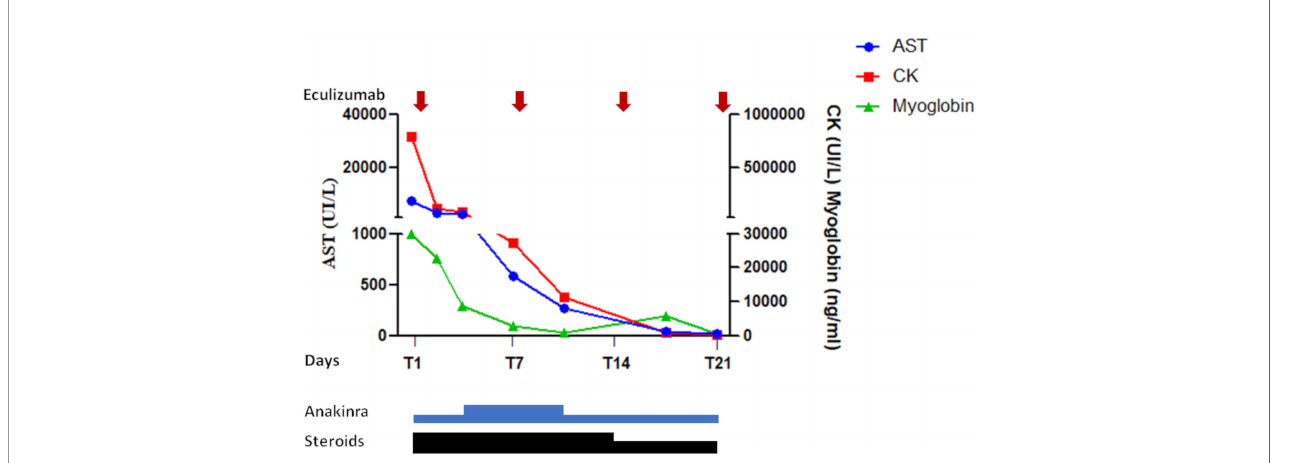
FIGURE 1 | Response to the multi-targeted treatment in the fi rst 21 days : A signi fi cant decrease of creatine kinase, myoglobin, and AST was achieved since the fi rst 36 hours from the treatment. A further progressive reduction was observed in the following days. Due to severe acute kidney injury anakinra was administered at the dose of 200 mg/die in the fi rst 3 days. The same dose was also administered from day+ 11. From day +4 to day +10 it was administered at the dose of 300 mg/die. From day +1 to 14 the patient also received methylprednisolone (100 mg/die), subsequently de-escalated to 60 mg/die. Vertical arrows indicate the four doses of